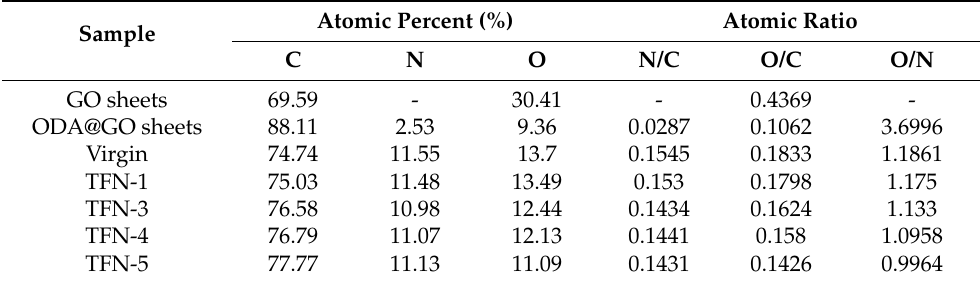
Table 2. Elemental composition of nanosheets and different RO membranes analyzed by